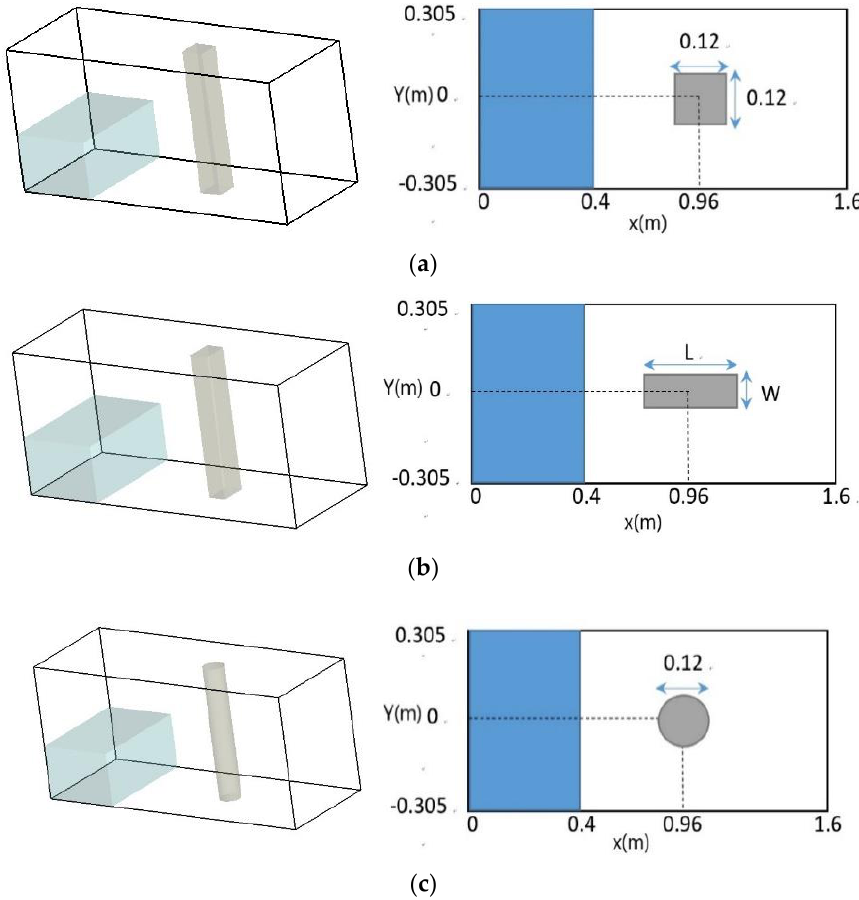
Figure 2. Schematic diagram of 3D dam-break flows over a ( a ) vertical square cylinder, ( b ) vertical rectangular cylinder with a different aspect ratio ( α = W/L ), ( c ) vertical circular cylinder. The volume of water is 0.4 × 0.61 × 0.3 m 3 .